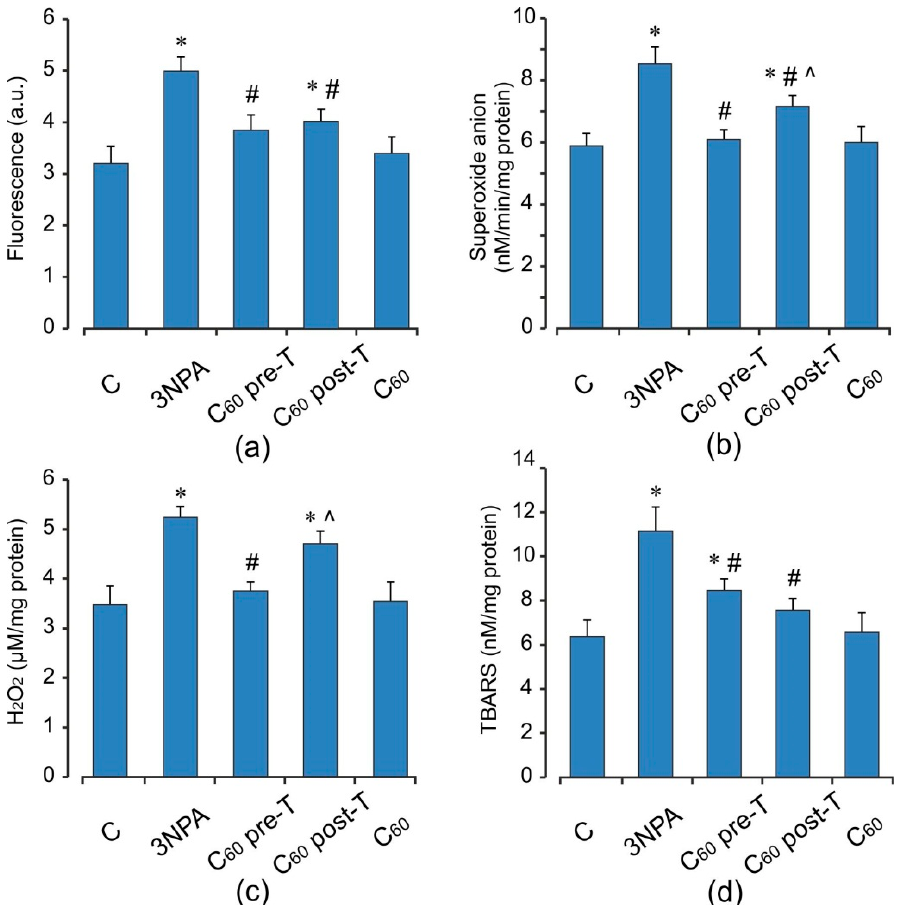
Figure 2. Effect of C 60 administration on oxidative stress markers: ROS formation ( a ), O 2 − ( b ), H 2 O 2 ( c ), and TBARS ( d ) production in brain mitochondria of 3-NPA-treated rats. Values are means ± SD (replicates = 8). The data were analyzed for statistical significance using ANOVA followed by the Bonferroni post hoc test. (C)—control; (3NPA)—3-nitropropionic acid treated rats; (C 60 pre-T)—C 60 administration in pre-treatment regimen; (C 60 post-T)—C 60 administration in post- treatment regimen; (C 60 )—C 60 administration alone. * p < 0.05 vs. control group; # p < 0.05 vs. 3-NPA treated rats; ^ p < 0.05 vs. C 60 pre-T group.